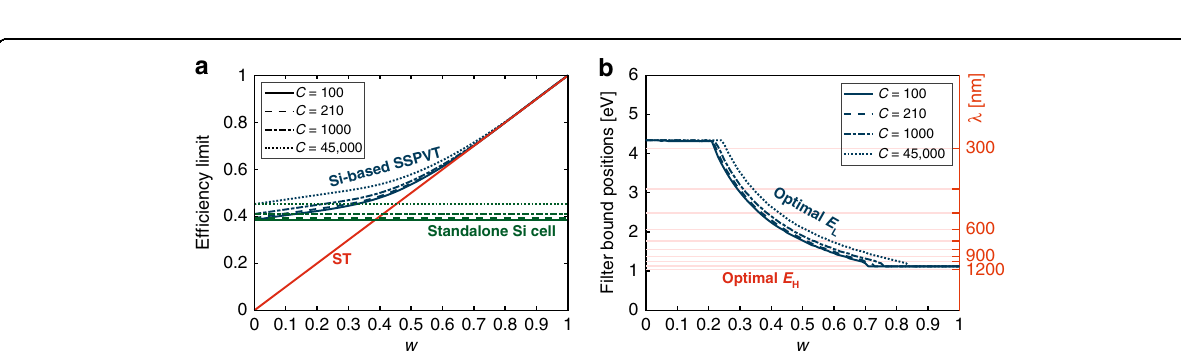
indicate the optimal lower bounds, upper bounds and maximum total effective ef fi ciencies for different w . We note that the value of w has a signi fi cant in fl uence on the total effective ef fi ciency limit and on the optimal fi lter.